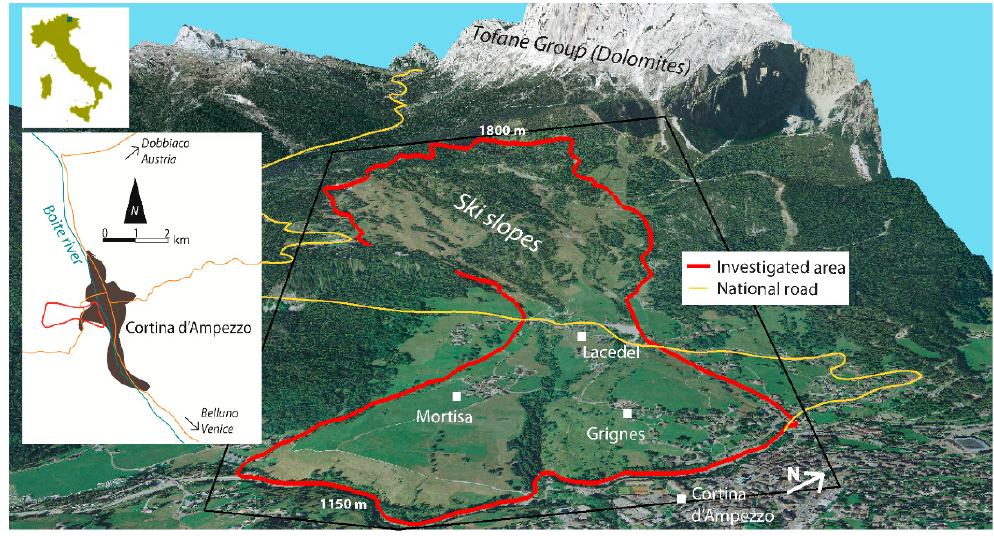
Figure 1. Study area. In black is the frame of Figure 2.